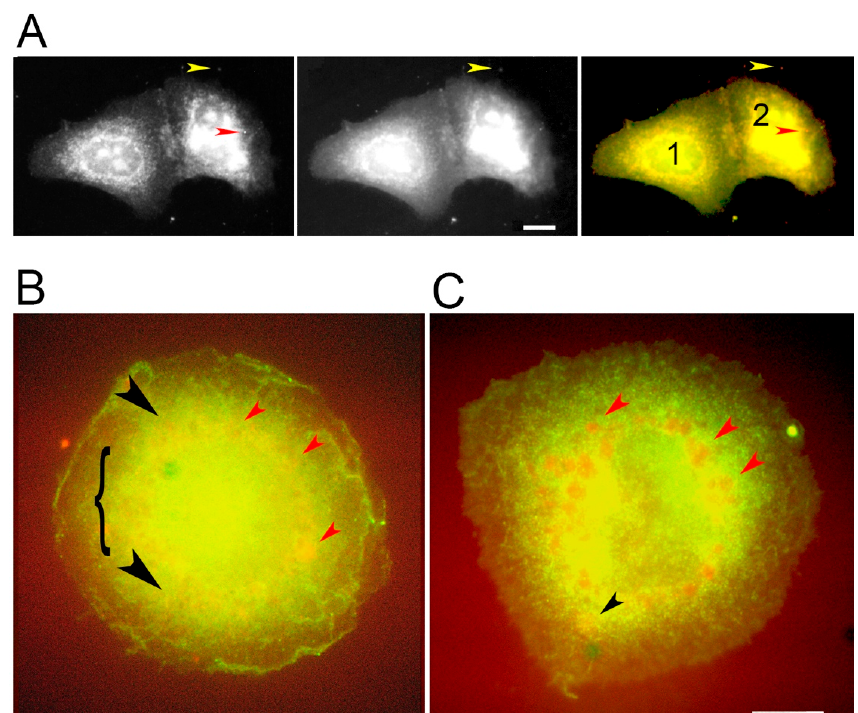
Figure 4. Colocalization of EGF-tagged nanoparticles with the GG form of PKC. ( A ) Projection of confocal planes showing rare locations where there are nanoparticles alone (left panel, red arrowhead) or together with PKC on a filopodium (yellow arrowhead) in PMA-treated cells. PKC (middle) is found with the nanoparticle (yellow arrowhead) and around or above the nucleus. Overlaid images (right) show both labels concentrated in a perinuclear ring (nucleus marked 1) or beside and above the nucleus marked 2. The cytoplasm shows homogeneous staining from the GG form of PKC (green). ( B ) A control cell, untreated during the 15-min chase, shows nanoparticles colocalized with the GG form in perinuclear sites (red arrowheads). Smaller colocalized clusters are found farther from the nucleus (black arrowheads) amidst a concentrated background of soluble PKC (bracket). ( C ) A cell treated with PMA during the 15-min chase shows large clusters of nanoparticles with little PKC GG in perinuclear locations (red arrowheads). A few smaller clusters are found farther away from the nucleus (black arrowhead). The bright green spot is an artifact. Bars = 10 µm. Biomolecules 2020 , 10 , x